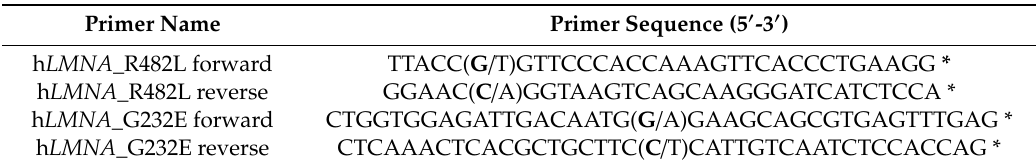
Table 1. Primers for site-directed